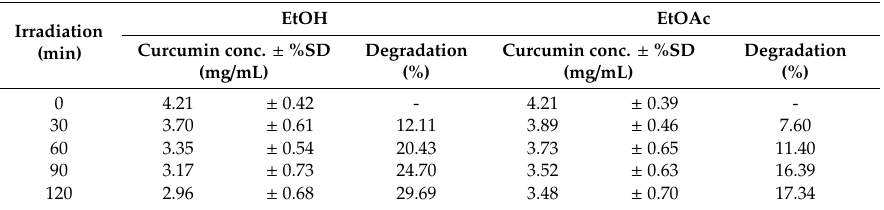
Table 1. Curcumin standard US degradation tests.